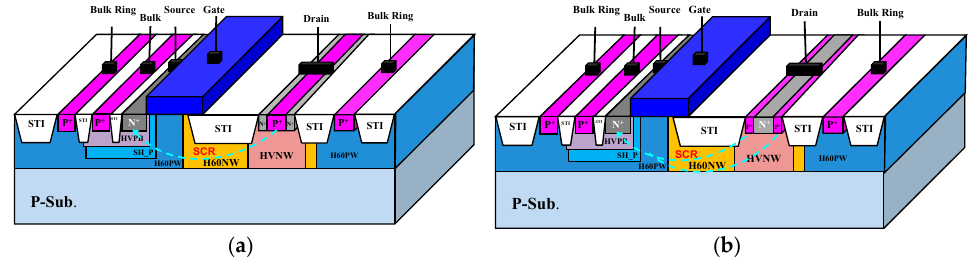
Figure 2. 3D structure diagram of an nLDMOS-silicon-controlled rectifier (SCR) stripe: ( a ) n-p-n - arranged and ( b ) p-n-p -arranged.